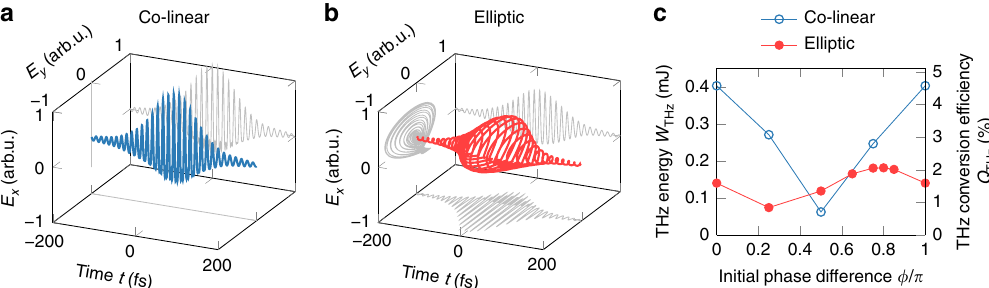
Fig. 5 Numerical simulation. Initial two-color fi eld with a collinearly and b elliptically polarized fundamental and second harmonic pulses. The initial phase differences ϕ between the ω and 2 ω fi elds are 0 for collinear and 0.8 π for elliptical polarization. c Dependence of THz energy and THz conversion ef fi ciency on the initial phase difference ϕ for collinearly and elliptically polarized ω and 2 ω fi